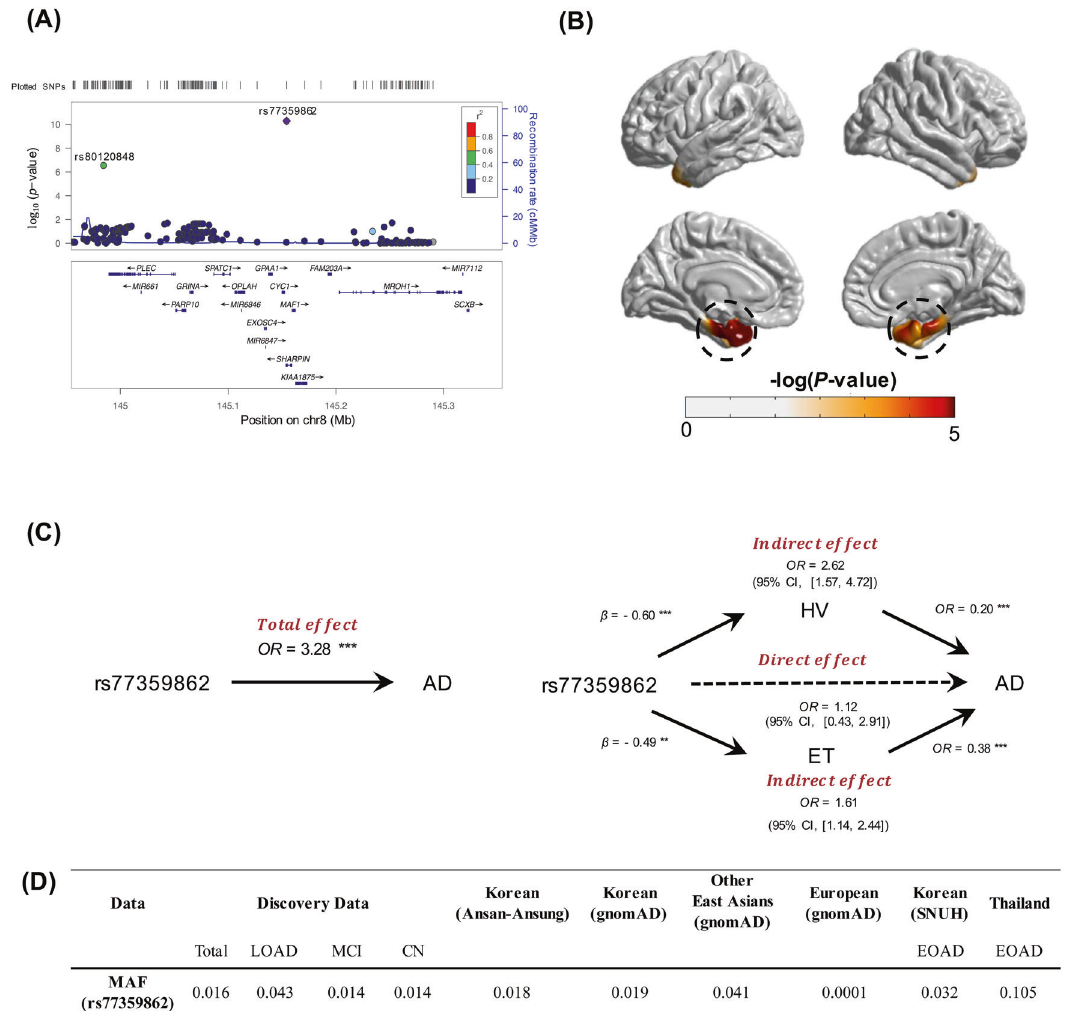
Fig. 1 Association of SHARPIN missense variant rs77359862 with AD and related traits. A Regional plot for the association of SHARPIN with hippocampal volume (HV). B Illustration of cortical atrophy in left and right hemispheres. A general linear model was applied to detect point- wise differences in whole-brains of 84 carriers and 2559 non-carriers of the rs77359862 missense variant. Rs77359862 carriers (bottom) show greater atrophy in the entorhinal cortex and hippocampus (highlighted in dotted black circles) compared to non-carriers. C Mediation analysis shows that the effect of rs77359862 on HV and entorhinal cortical thickness (ET) mediates the association of rs77359862 and AD risk. The total effect represents the impact of rs77359862 on the odds of AD without considering indirect effects of the variant through the hippocampus and entorhinal region, whereas the direct effect is calculated controlling for its effect on HV and ET which are both associated with AD. Each indirect effect was obtained by adjusting for the other mediator; β regression coef fi cient. OR odds ratio, 95% CI 95% con fi dence interval of 10,000 bootstraps; ** p -value < 0.01, *** p -value < 0.001. D Frequency of the rs77359862 missense variant in late-onset AD cases, early-onset AD (EOAD) cases, mild cognitive impairment (MCI) cases, and cognitively normal (CN) persons in clinical samples from Korea and Thailand and in several reference populations. Other East Asians exclude Korean and Japanese. Detailed information for EOAD data is provided in supplementary Text 6. SNUH Seoul National University revealed signi fi cant associations with SHARPIN in both the ADNI (86 SNPs, p = 0.002) and AddNeuroMed (93 SNPs, p = 0.04) datasets. Other suggested signi fi cant variants with HV from Table 1 were not signi fi cant in the ADNI dataset (EPPK1: 35 SNPs, p =